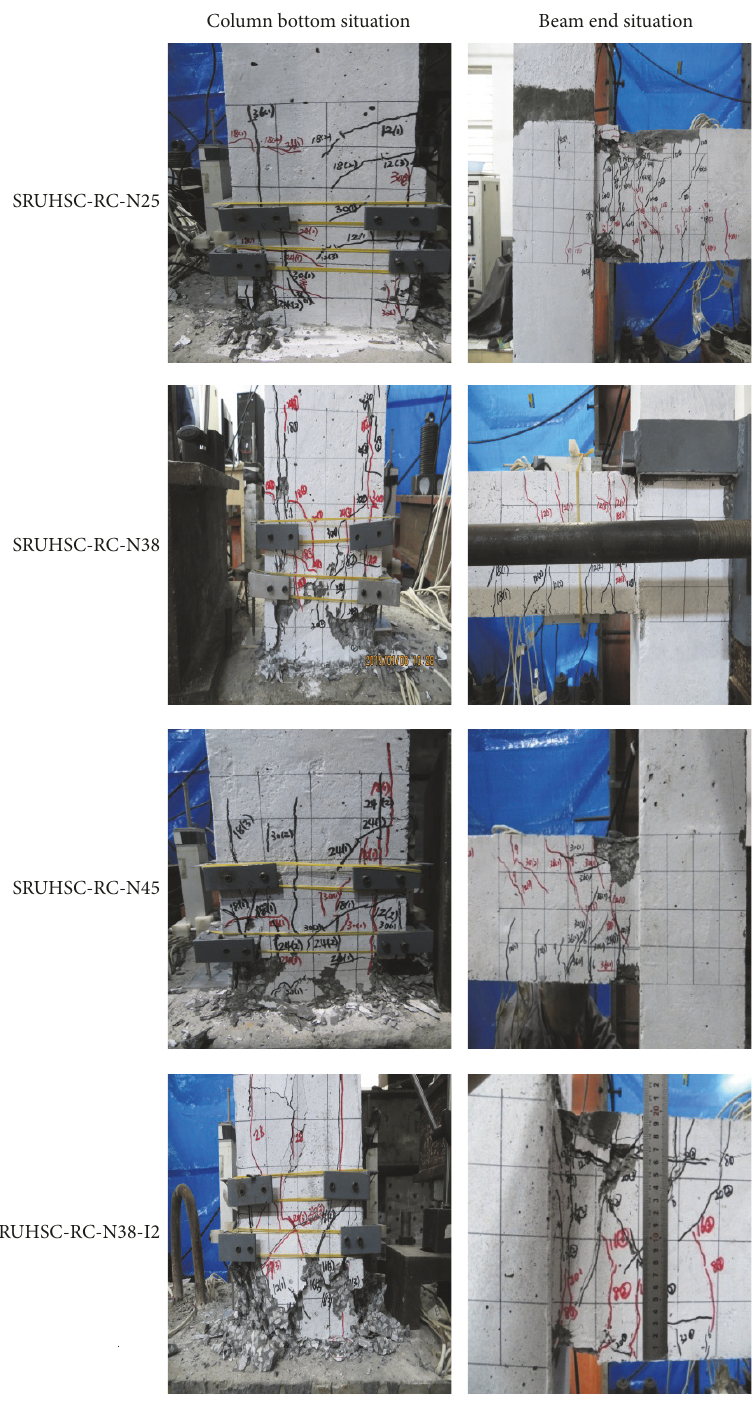
Figure 5: The ultimate destruction style of the beam and